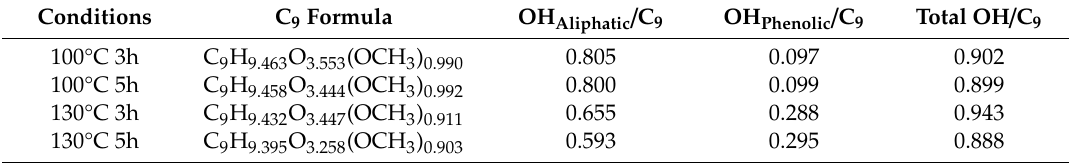
Figure 6. Molecule-weight distribution curves of lignin in the jute fibers pretreated for 3 and 5 h. Table 1. Hydroxyl concentrations of lignin in the jute fibers pretreated for 3 and 5 h.